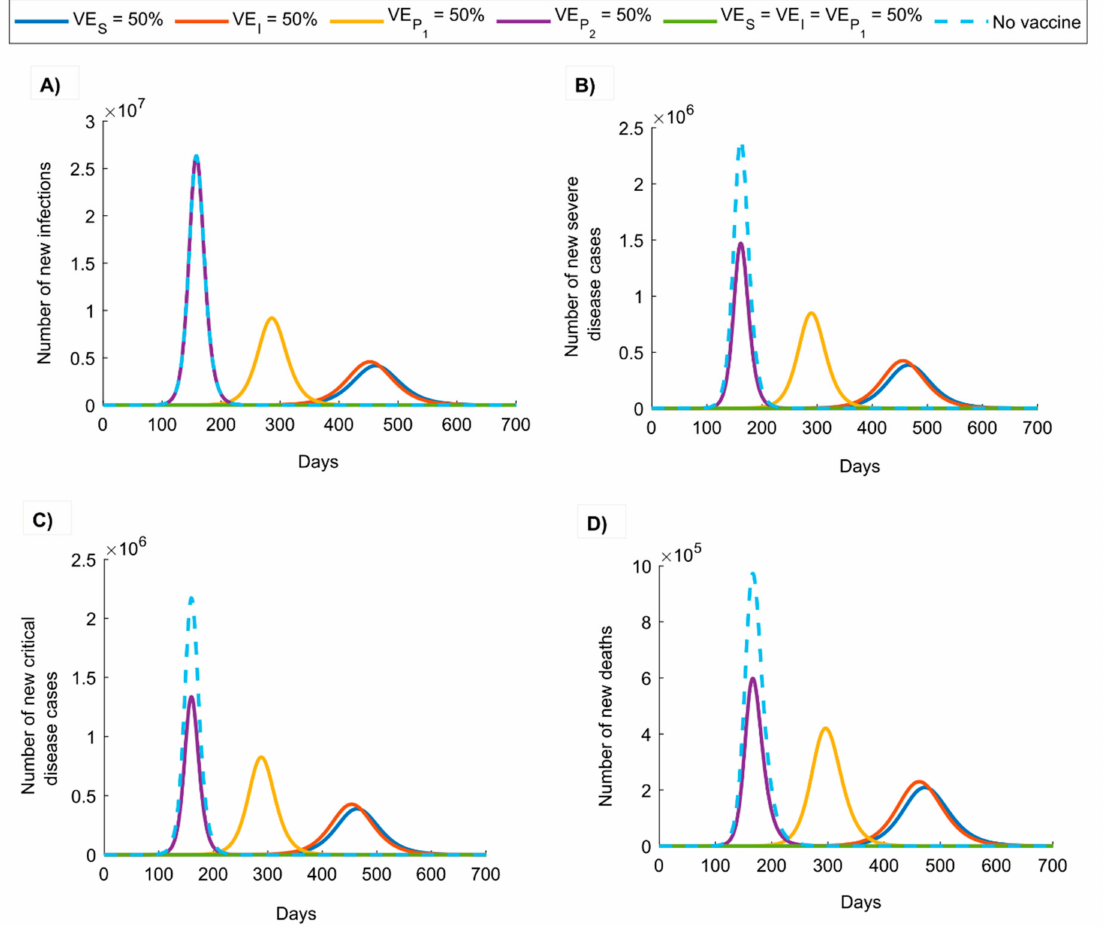
= 50%, VE = 50%, VE = VE = VE = P 2 I P 1 S 1